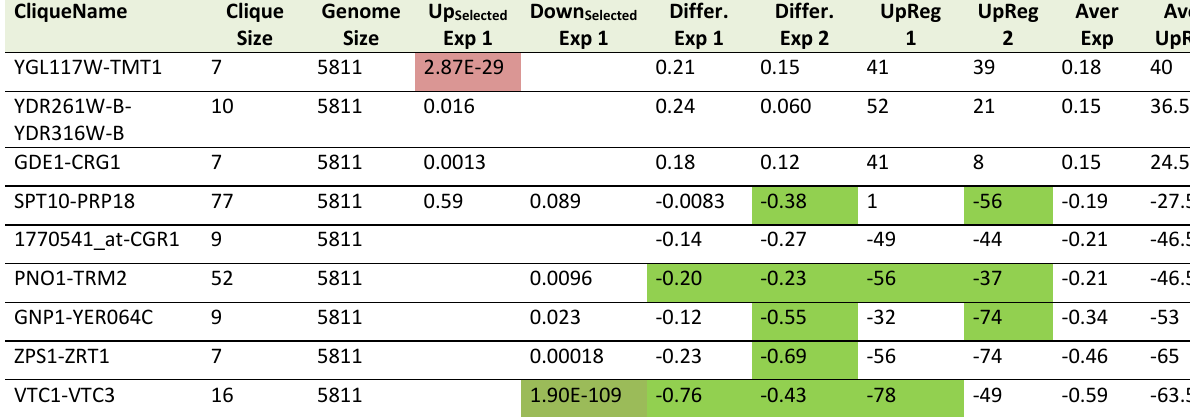
TABLE 7. Most prominent hits from differential expression between Q30 and Q0 within the 72 expression cliques.